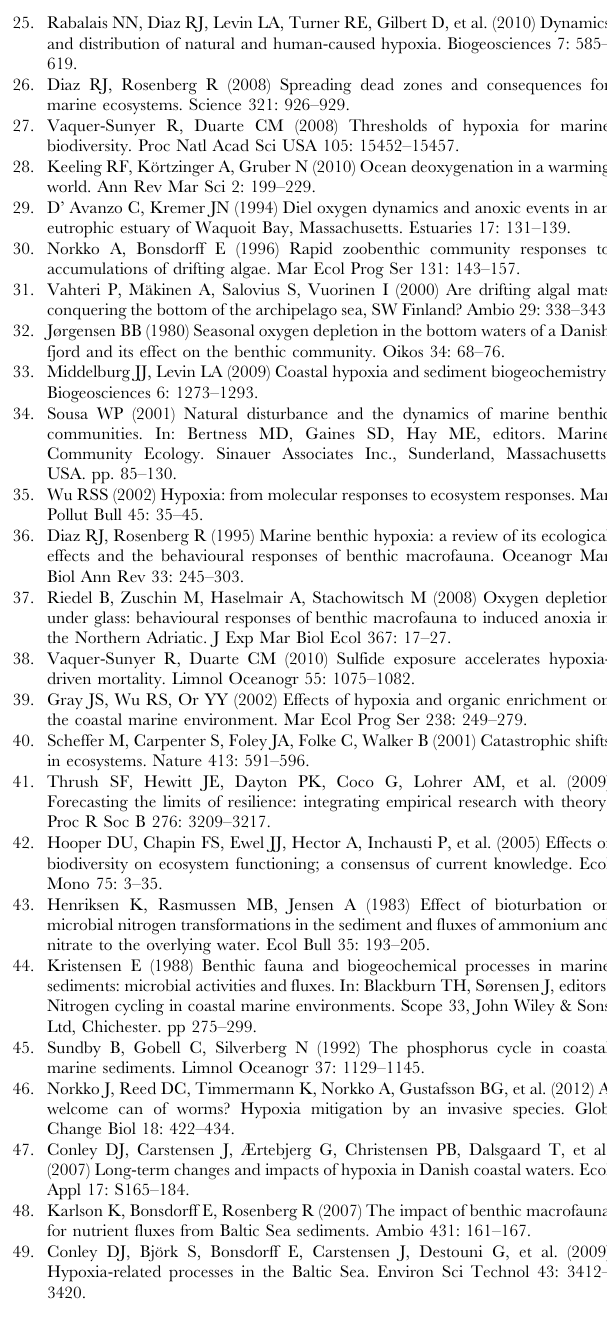
Table S2 Results of nonlinear regression analyses and analyses of variance. The effects of increasing hypoxic duration on benthic parameters were illustrated with nonlinear regression analyses (sigmoidal logistic 3 parameter equation, c.f. Fig. 1a and Fig. 2). A power function was used to depict the sediment desorption-sorption capacity for PO 43 2 . One-way ANOVA was used to detect differences between treatments for abiotic